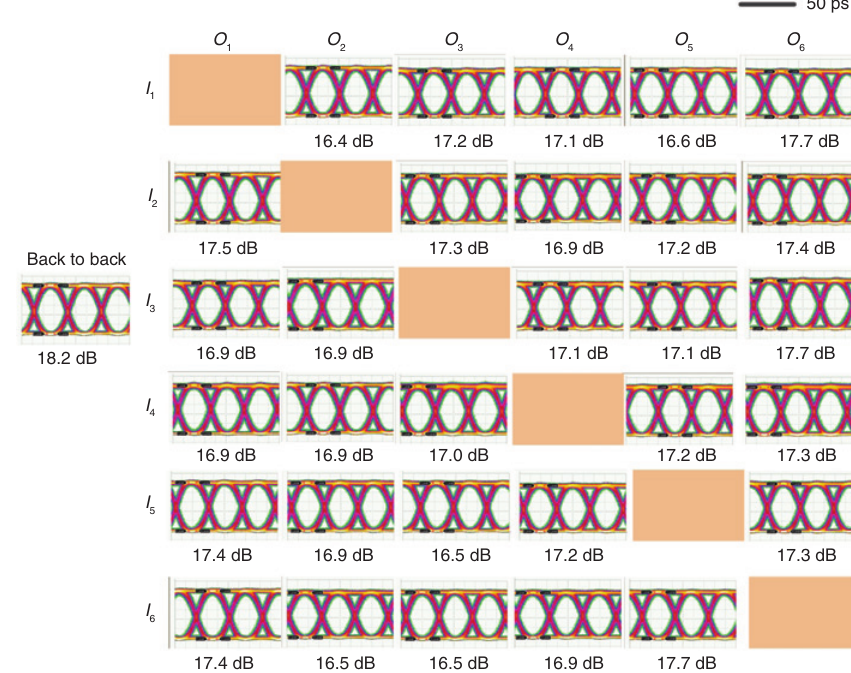
Figure 5: Eye diagrams for the 30 optical links of the six-port optical switch at the wavelength of 1550 nm.